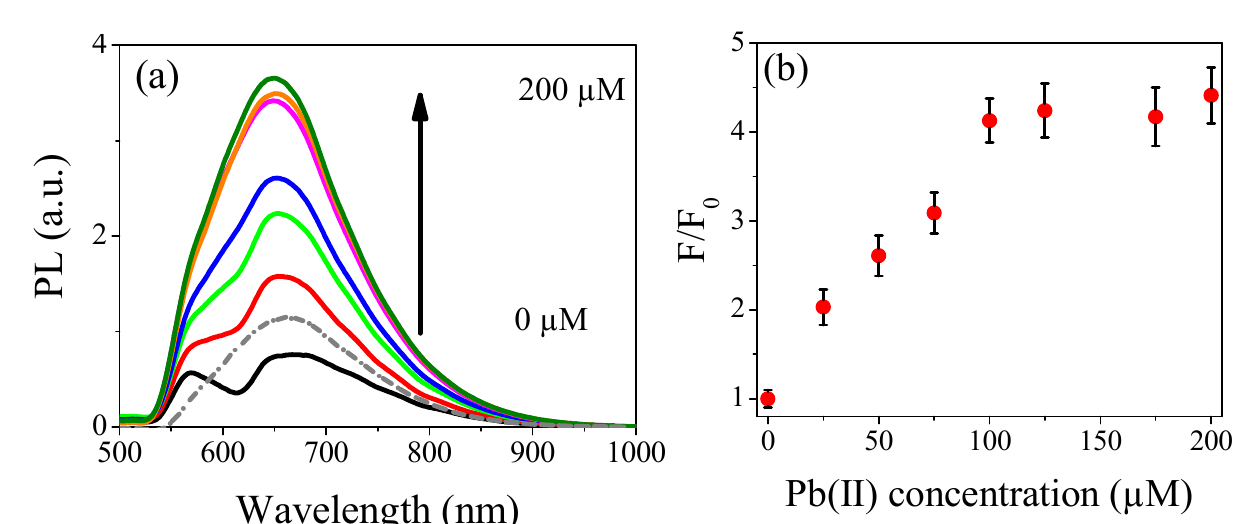
Figure 3. ( a ) PL spectra of the hydrogel matrix doped with AgNCs-PMAA as a function of Pb(II) concentration, the dotted grey line represents the emission of bare AgNCs-PMAA colloidal solution as reference; ( b ) the F/F 0 ratio as a function of Pb(II) concentration between 0–200 µM .